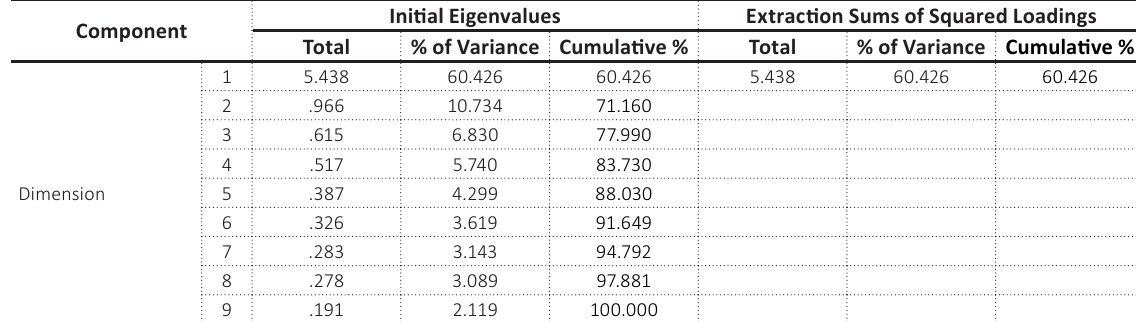
Table 4. Total variance explained